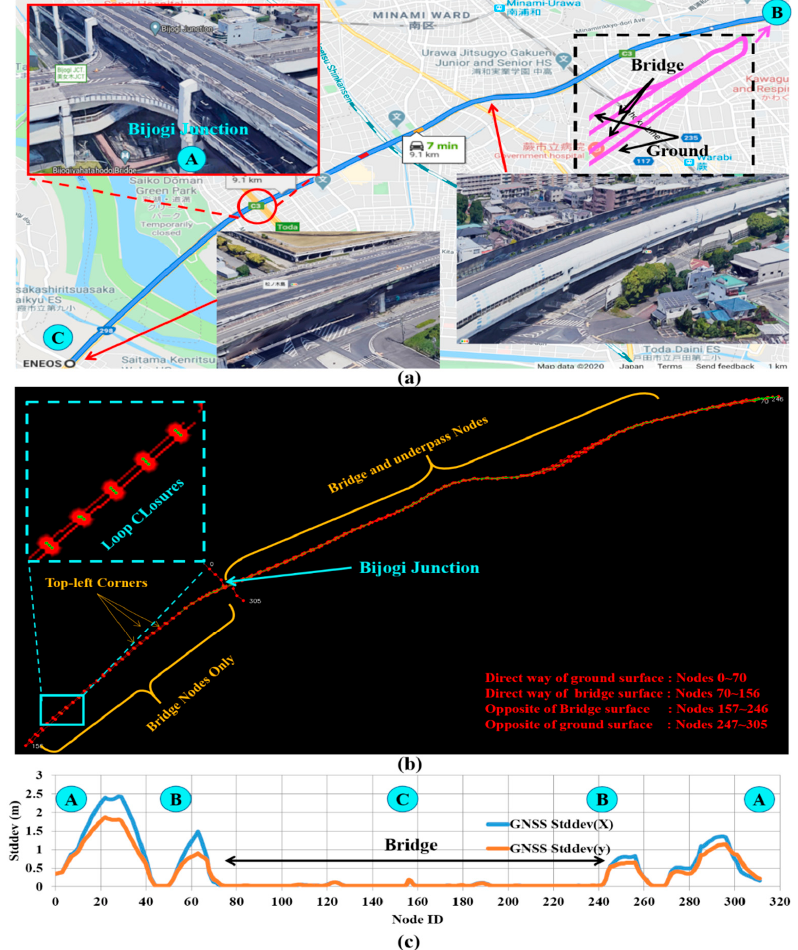
Figure 13. Mapping multilevel Bijogi Junction with longitudinal bridge and underpass. ( a ) The course representation showing continuous covering of the underpass by the wide bridge shoulders. ( b ) Nodes’ top-left corner distributed in ACS based on GIR coordinates with indicating the